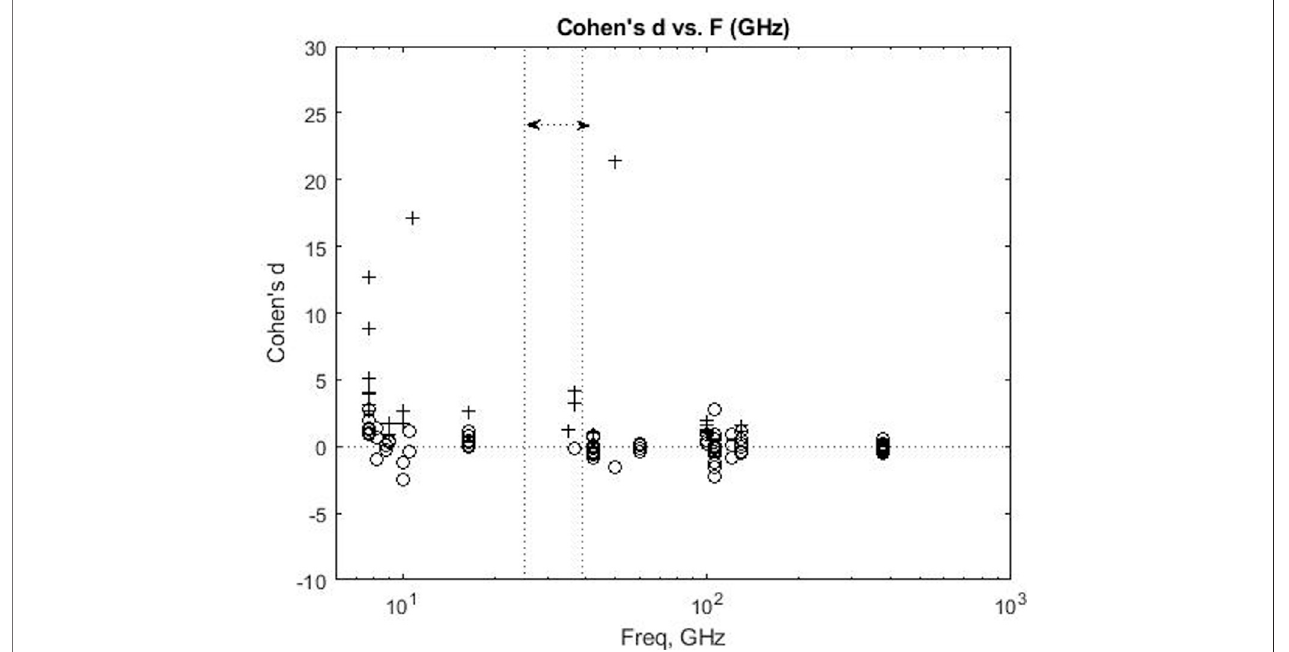
FIGURE 3 | Effect size (Cohen ’ s d) vs frequency of exposure for 157 experiments reported in 31 studies. Vertical dotted lines indicate the 5R NR “ high band ” at 25 – 39 GHz. Experiments reporting statistically signi fi cant/not statistically signi fi cant effects of exposure are indicated by + and o respectively.